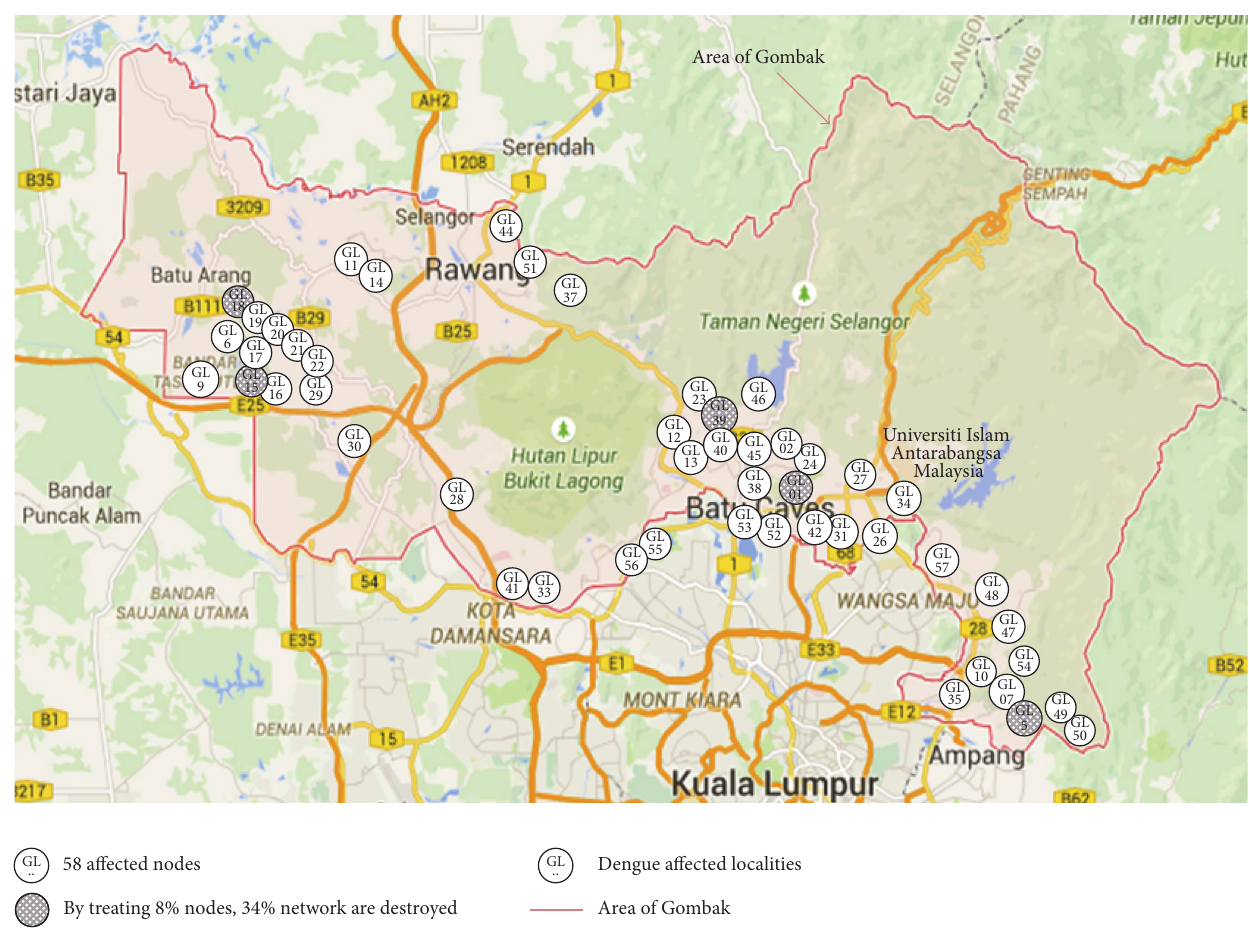
Figure 7: Real map of Gombak with 58 dengue affected nodes, where 8% most affected nodes are in grey dotted coloured [image adopted from google maps and